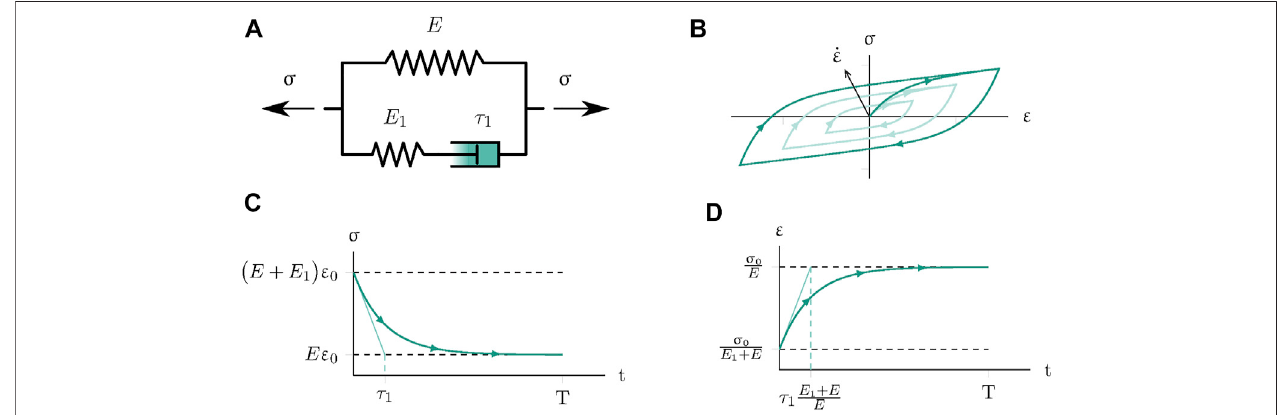
FIGURE 4 | One-dimensional viscoelastic material behavior. (A) Poynting-Thomson rheological model. (B) Cyclic loading hysteresis for constant strain rates _ ε . (C) Stress relaxation response to a unit-sized step ε ( t ) (cid:1) ε 0 H ( t ). (D) Creep retardation response to a unit-sized step σ ( t ) (cid:1) σ 0 H ( t